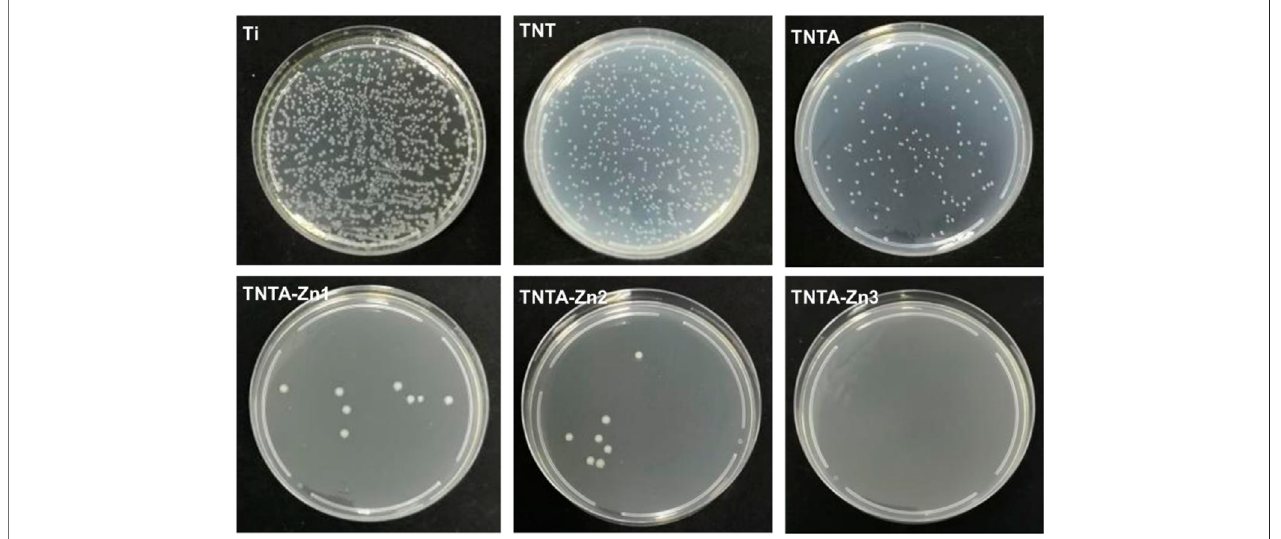
FIGURE 9 | Antibacterial properties of the different samples using Escherichia coli as the model bacteria.